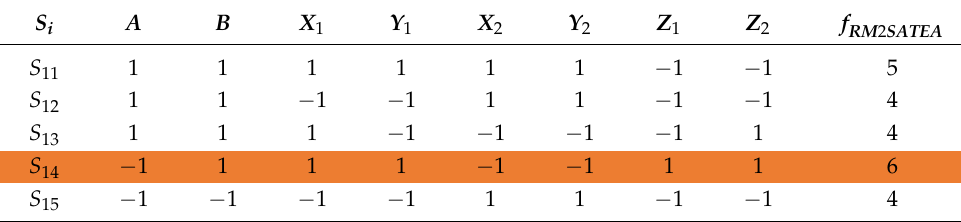
Table A3. S 14 selected as candidate in Party 3.